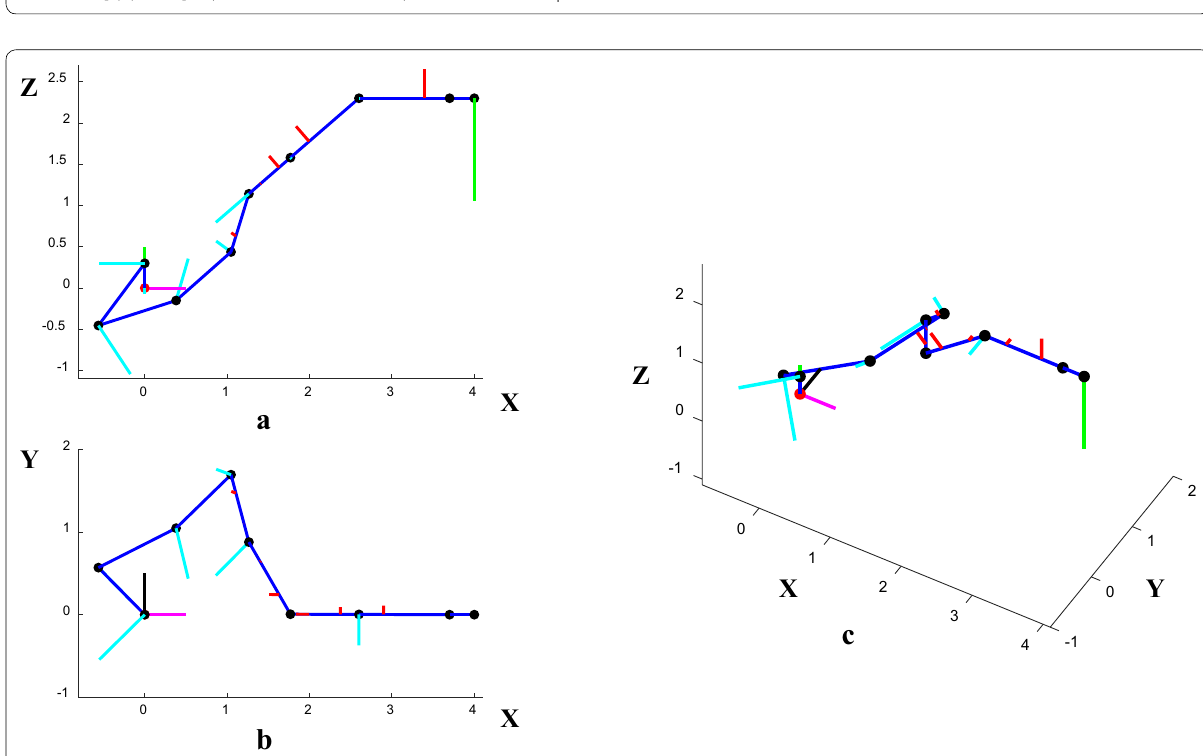
Fig. 12 The simulation arm and flying watch thrusts under the first level watch-actuator cooperation when the external reaction force on the end effector is [0,0, 125] N (reduction rate 1.0%). a Front view. b Top view. c 3-D view − = −